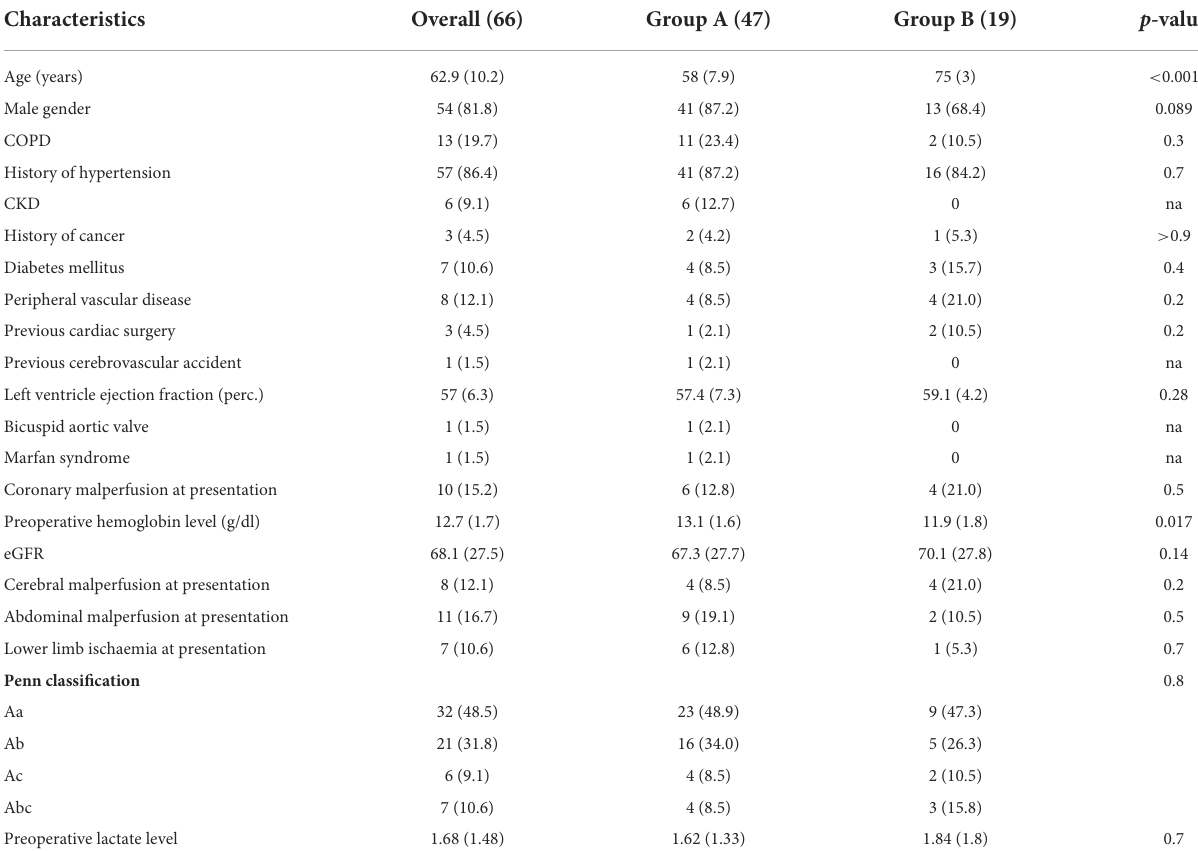
TABLE 1 Preoperative characteristics.